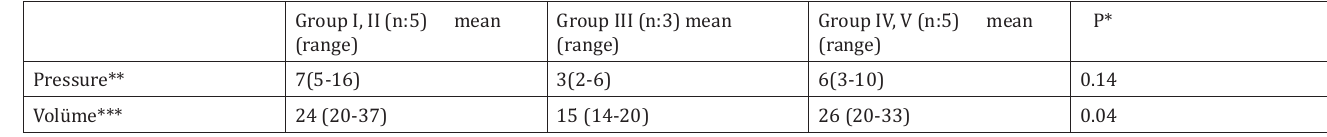
Comparison of pressure and volume measurements between the control groups (Group I + Group II), partial cystectomy only group (Group III) and the BAMA augmented cystoplasty groups (Group IV +Group